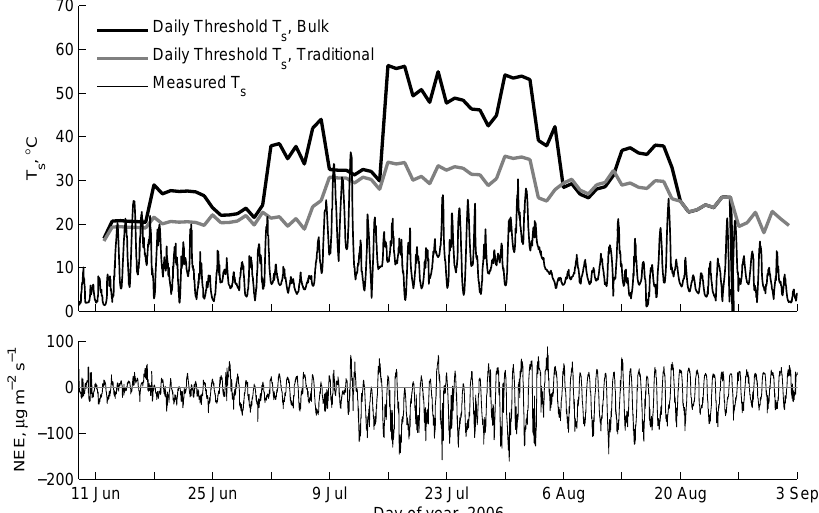
Fig. 5. Ecosystem sensitivity to surface temperature, with respect to positive mid-day CO 2 fluxes generated using measured PAR time series for the 2006 growing season with model parameters generated as described in the text (Eq. 6). Surface temperatures higher than the threshold would enable net positive mid-day CO 2 fluxes. The NEE time series is re-printed from Fig. 1 in the lower panel to ease